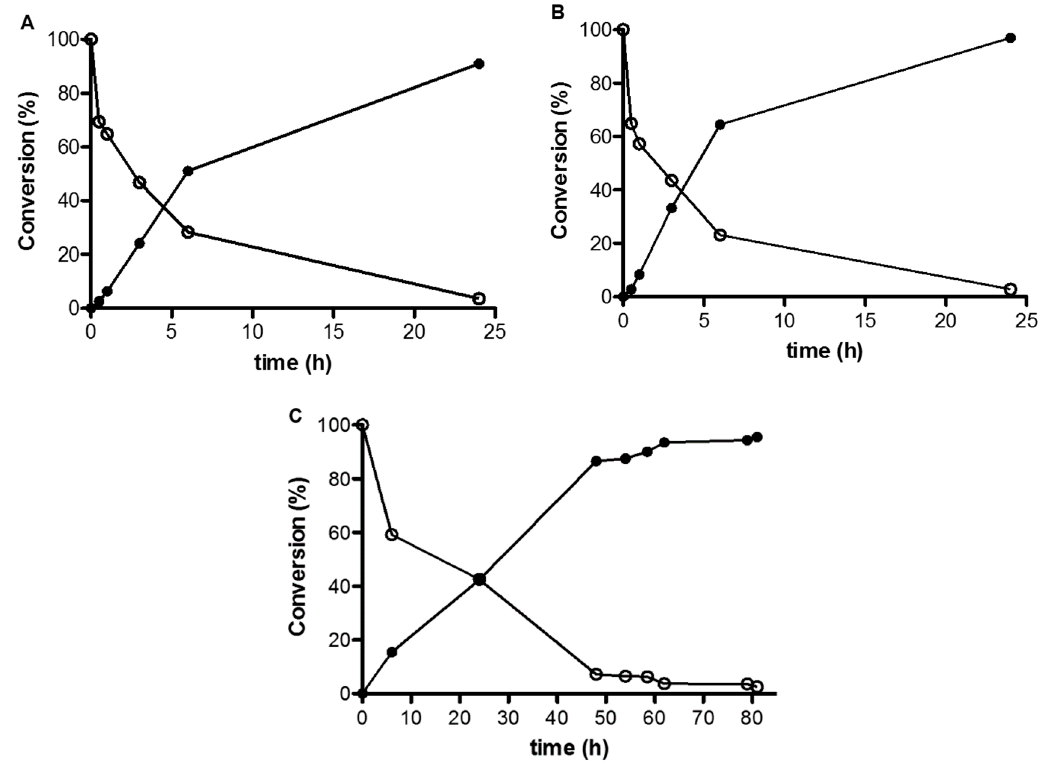
Figure 2. Time course of araA-MP synthesis (scale-up): araA-MP (black circle) and adenine (hollow circle). ( A ) 5 mM, ( B ) 10 mM, ( C ) 25 mM. Experiments were performed in duplicate. The data points are mean values of duplicate reactions. Deviation from mean values was below 5%.